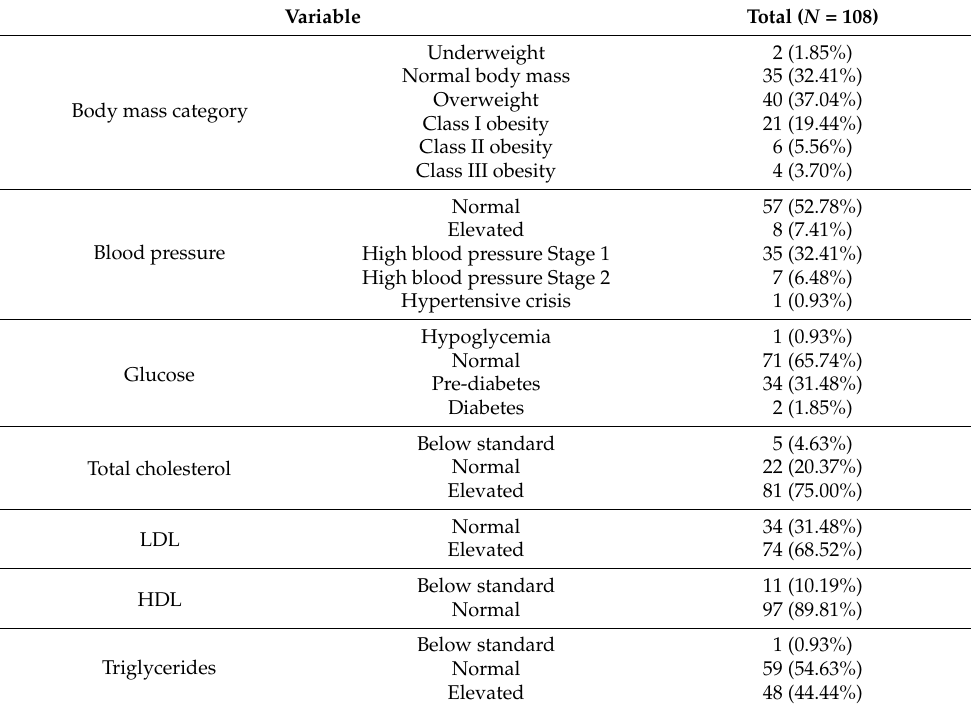
Table 3. Category of variables in the study